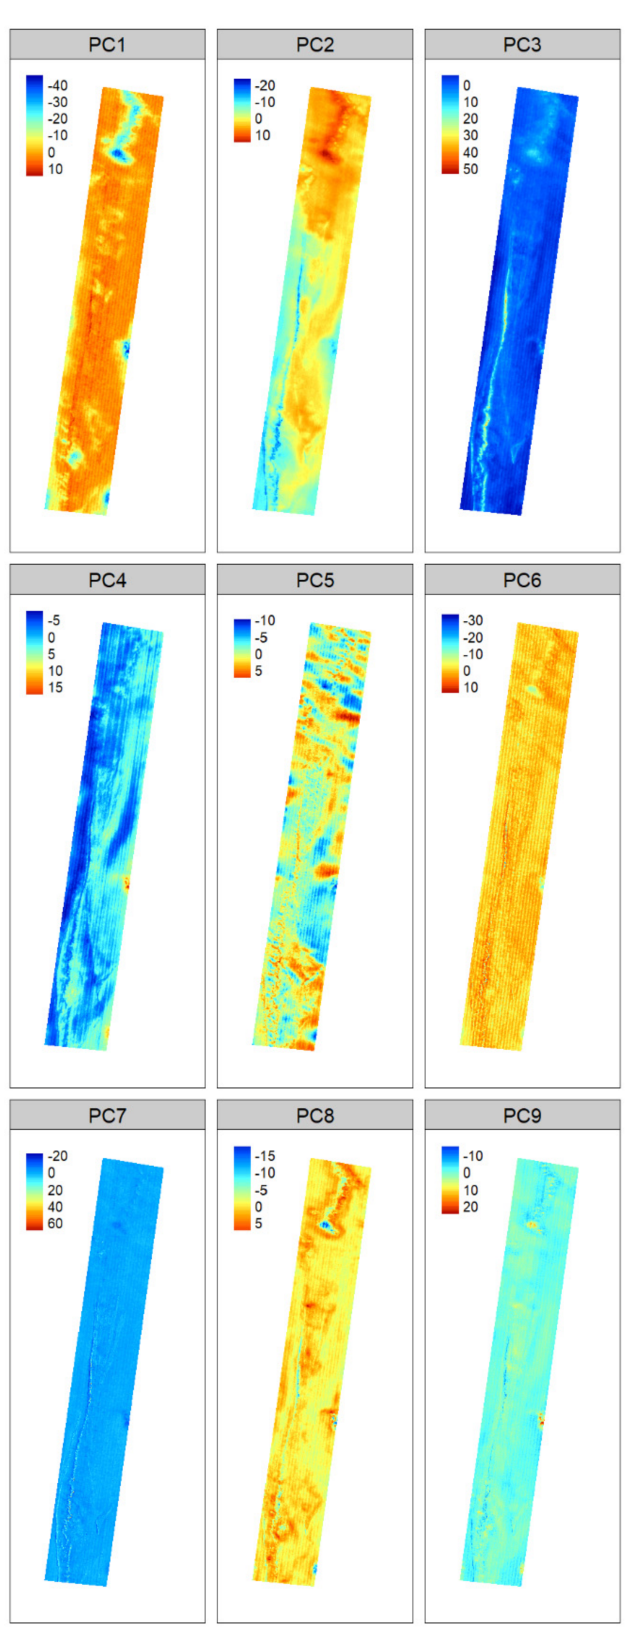
Figure 9. Plot of the nine retained principal components for use in the k -means clustering